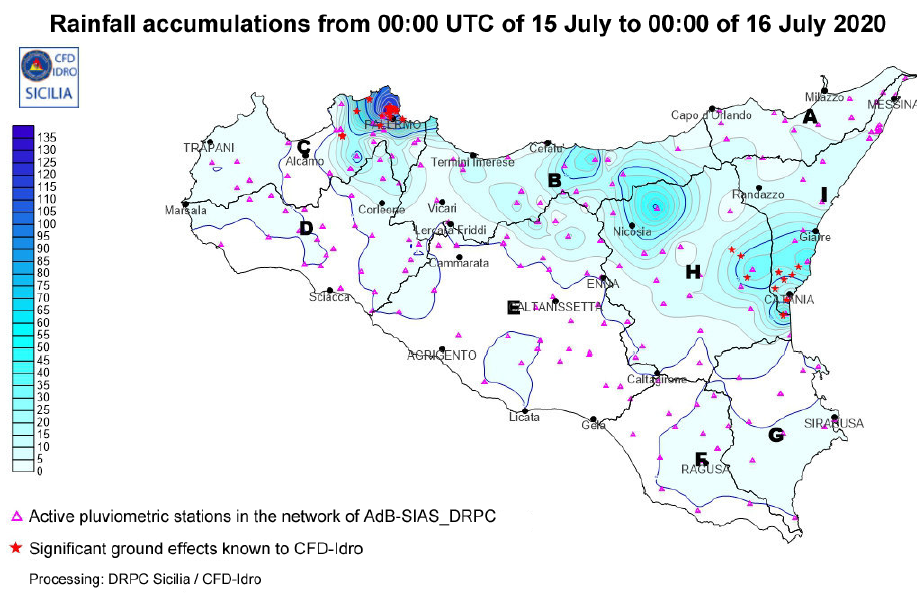
Figure 16. Rainfall accumulations (in mm) in the 24 h from 00:00 UTC of 15 July to 00:00 UTC of 16 July 2020.